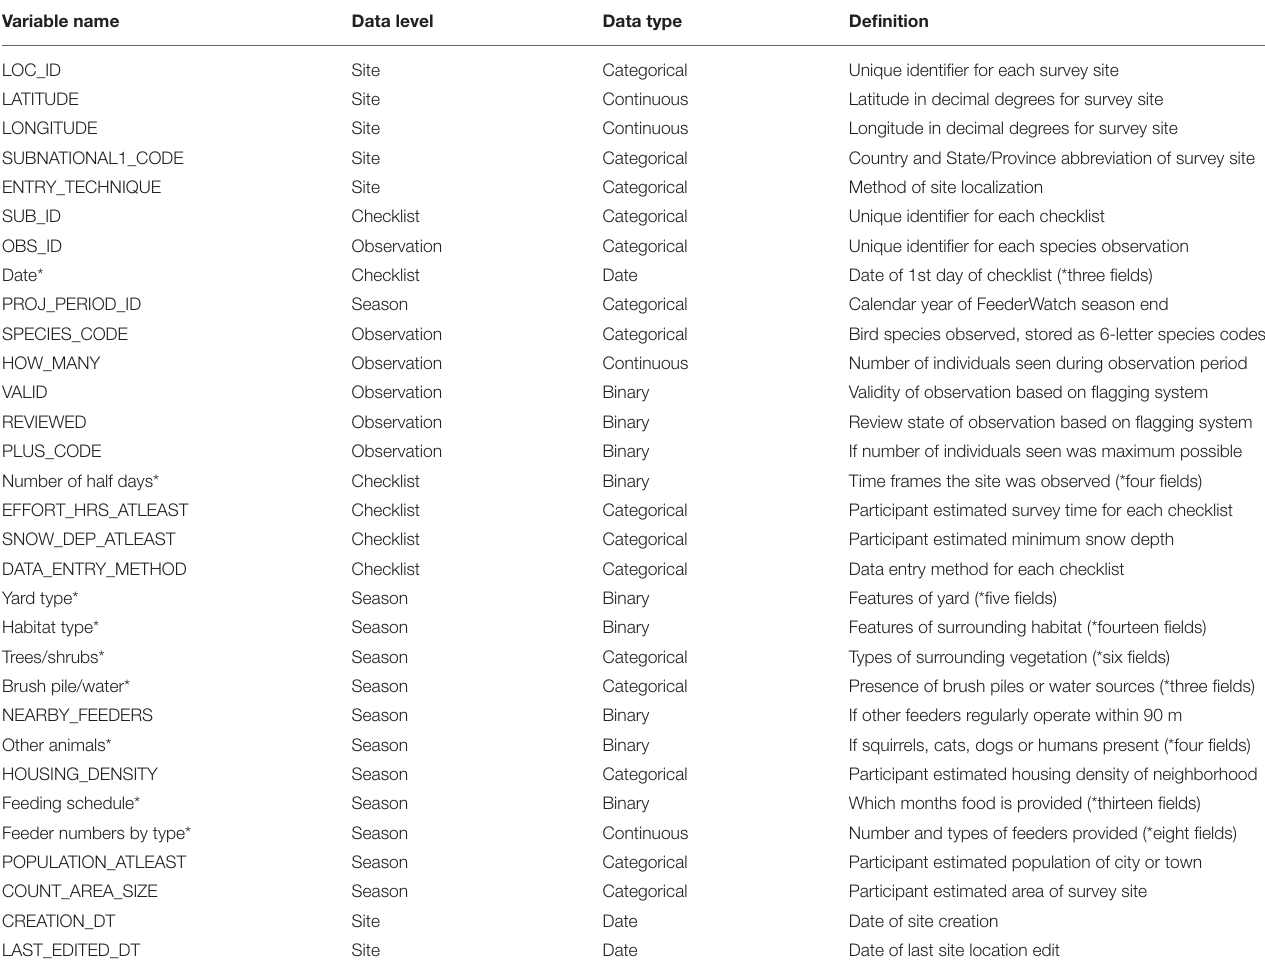
TABLE 1 | List of variables provided in project FeederWatch